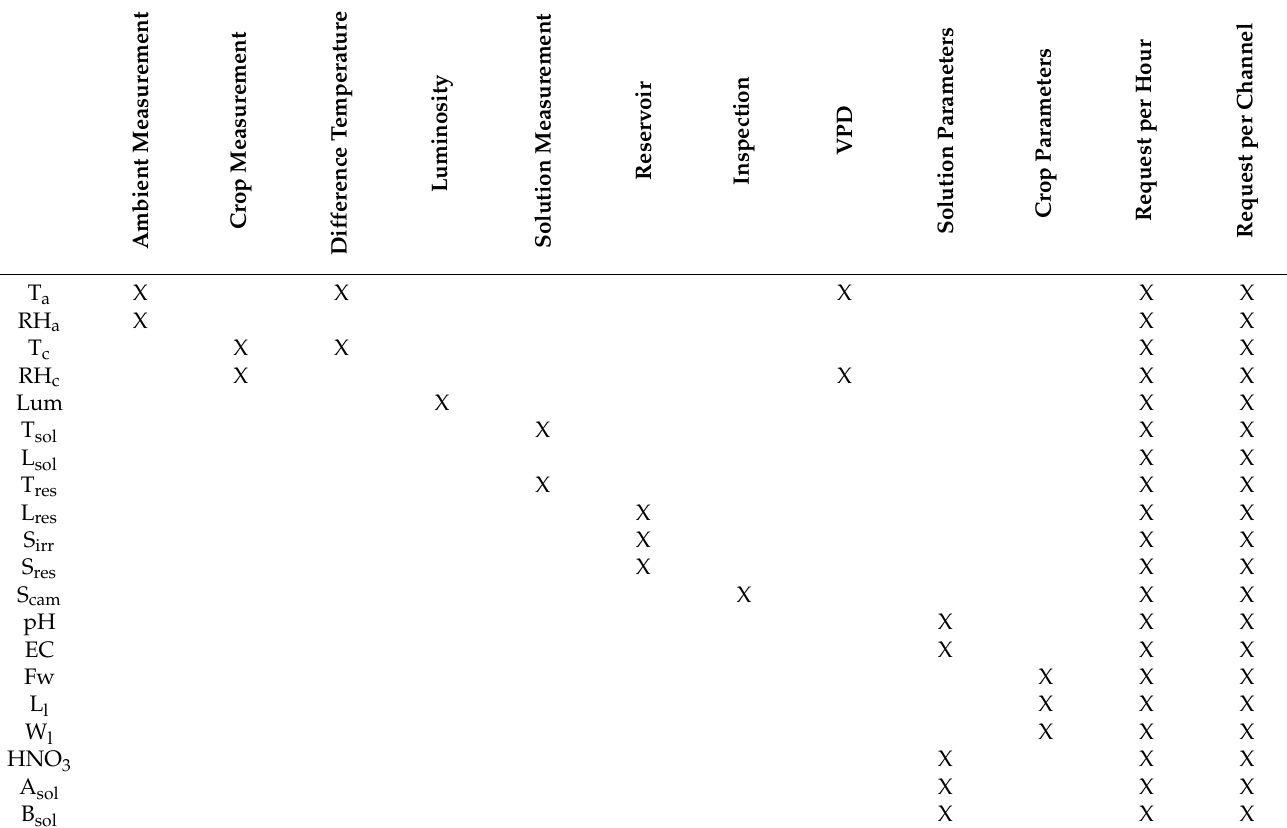
Table 3. Variable—Report Relationship using MATLAB Analysis and